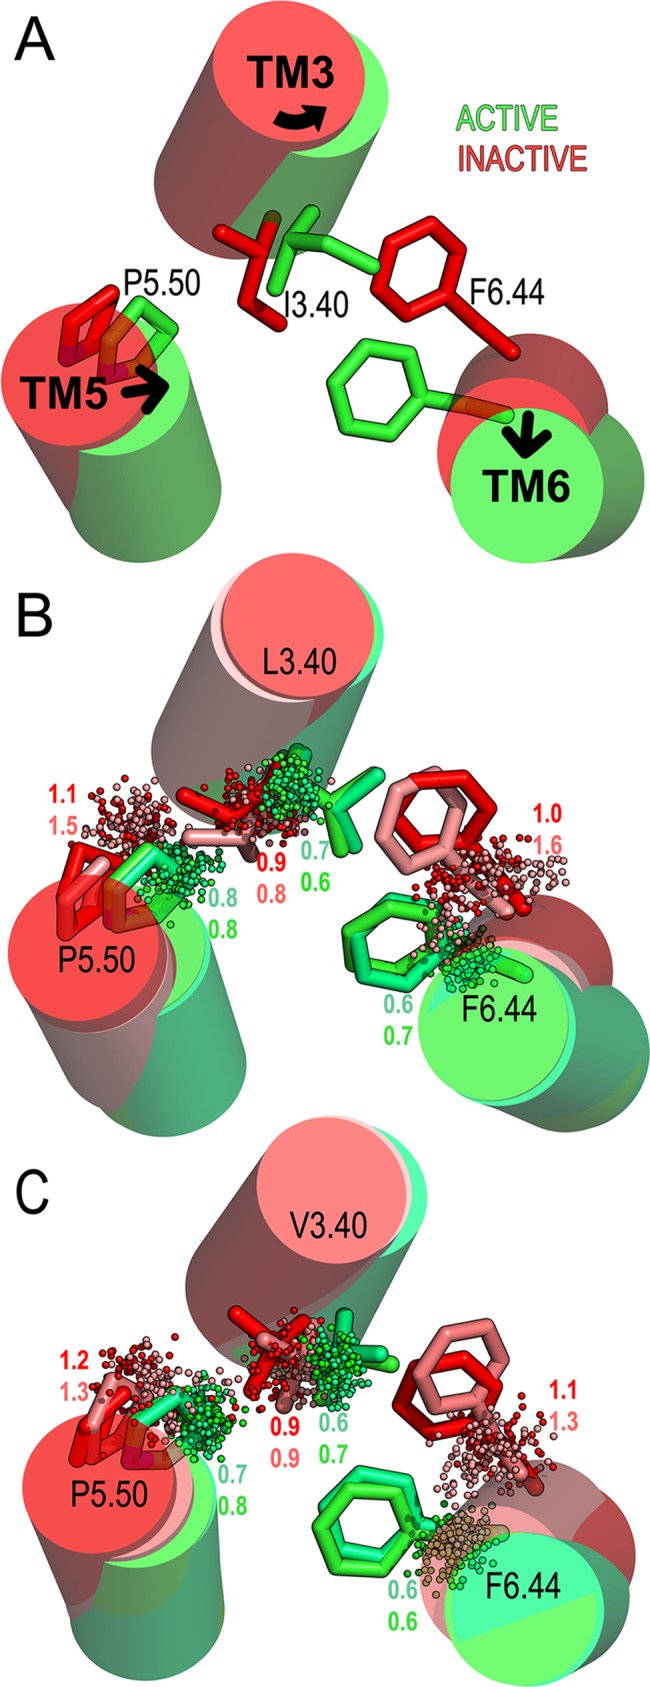
Effect of PUT and CAD on the ‘transmission switch’ amino acids.(A) Structural attributes of the ‘transmission switch’ residues 3.40, 5.50 and 6.44 (in sticks), in TMs 3-5-6 (in cylinders), on the ADRB2 in agonist bound active- (PDB ID: 3SN6, in green) and inverse agonist bound inactive- conformation (2RH1, in red). Arrows represent the observed movement of the helices in the transition from the inactive to the active state of the receptor. (B) Distribution of L3.40, P5.50 and F6.44 Cβ atoms positions (dots) in the TAAR6 and (C) V3.40, P5.50 and F6.44 Cβ atoms in the TAAR8 during simulations of active-like PUT/CAD bound in green/light green and inactive-like PUT/CAD bound in red/light red. Numbers correspond to the standard deviation (SD) of the Cβ atoms positions from the centroid of 100 evenly spaced snapshots extracted from the 1.0 μs of unbiased MD simulations.